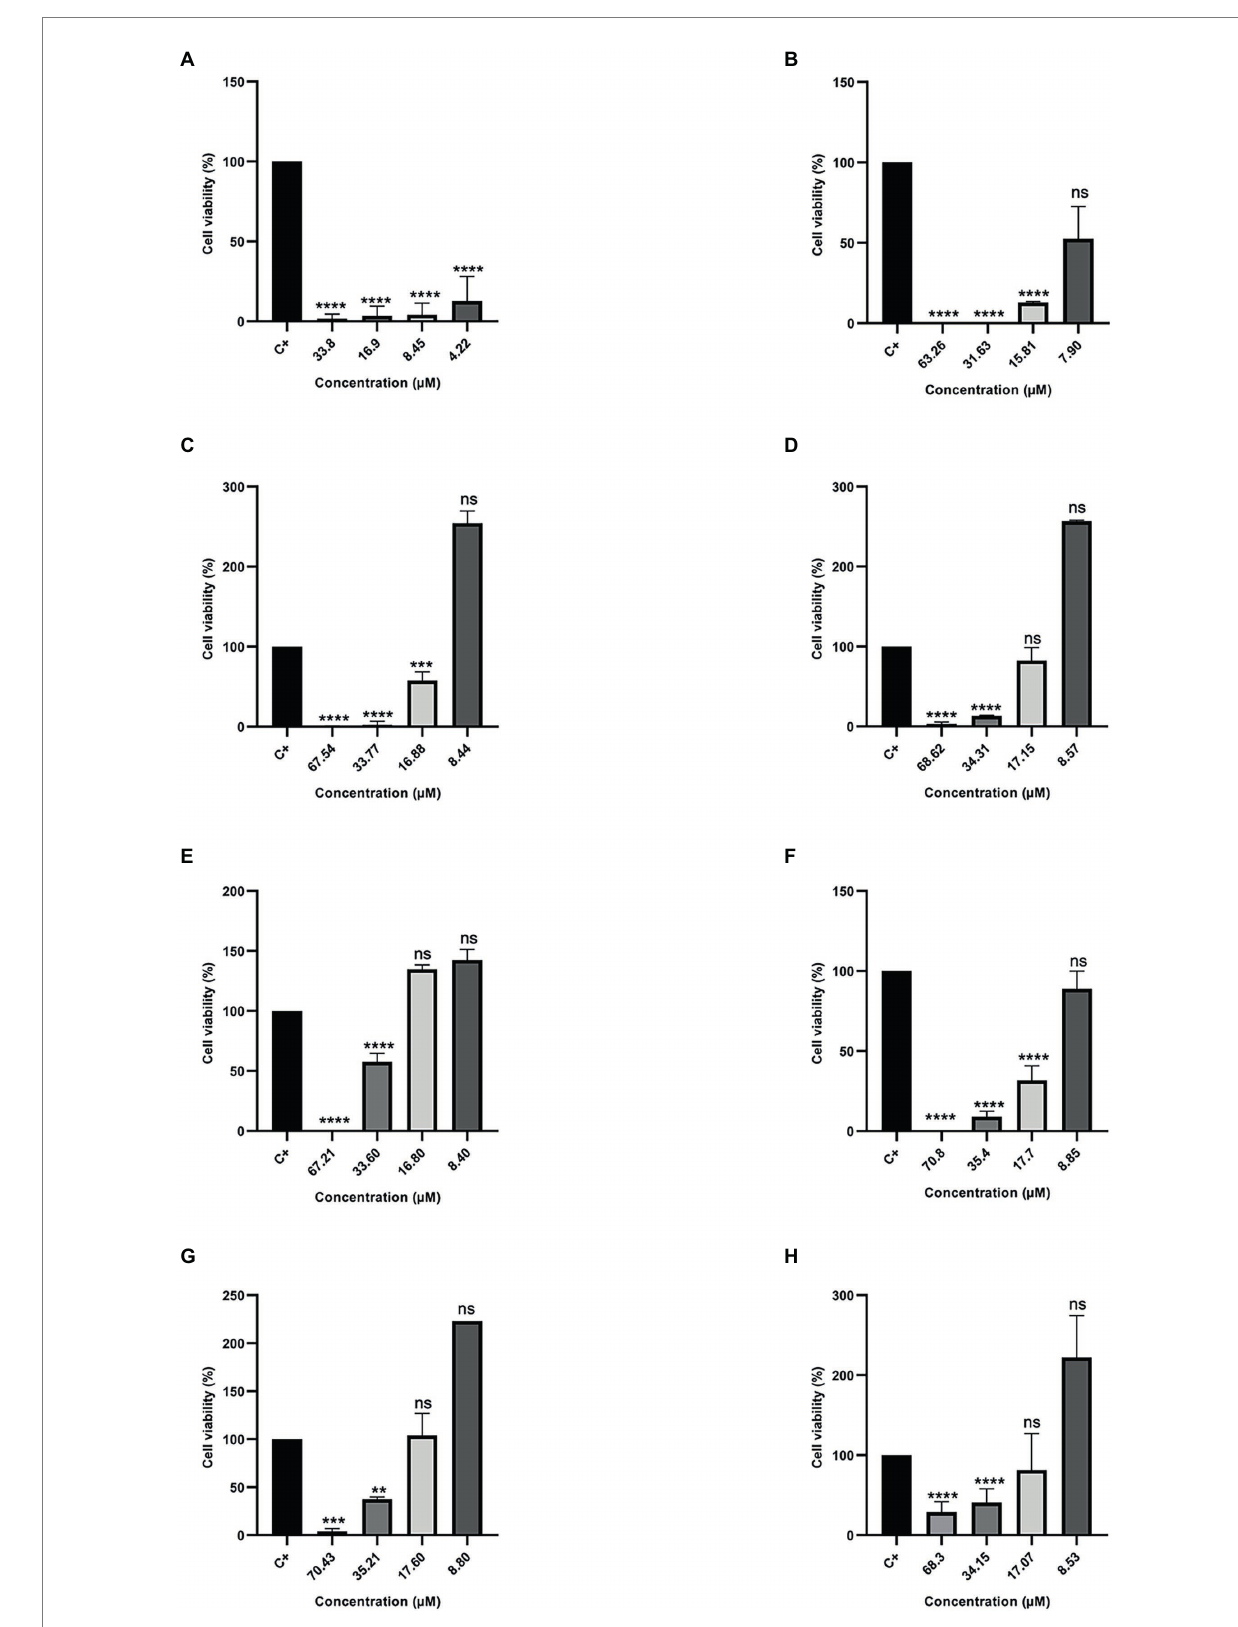
FIGURE 5 Percentage of Cell Viability in MDA-MB231 cancer cells. (A) Cu-1a; (B) R1a; (C) R1b; (D) R2b; (E) R3b; (F) R6b; (G) R8b; and (H) R10b. One-way ANOVA—Bonferroni’s multiple comparisons test. Each bar represents the mean ± SD of cellular absorbance; N = 3. * p < 0.05, ** p < 0.01, *** p < 0.001, **** p < 0.0001, and NS p >